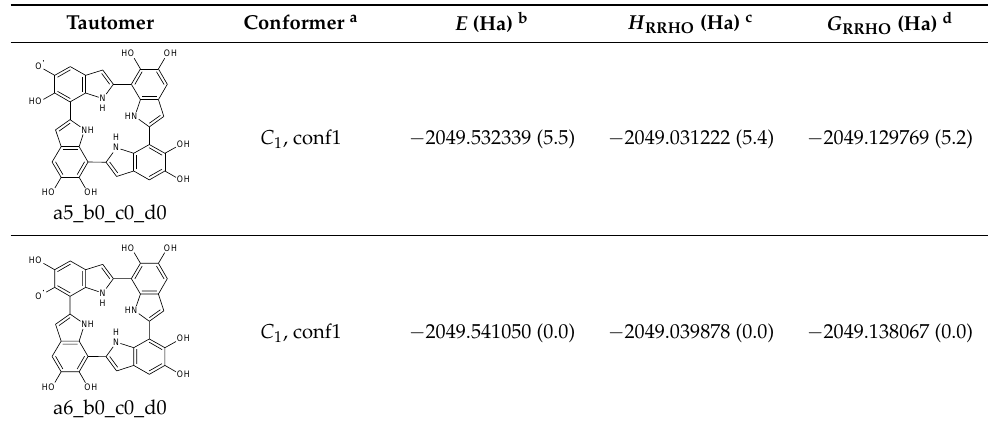
Table 4. KP-1e, neutral form in vacuo.